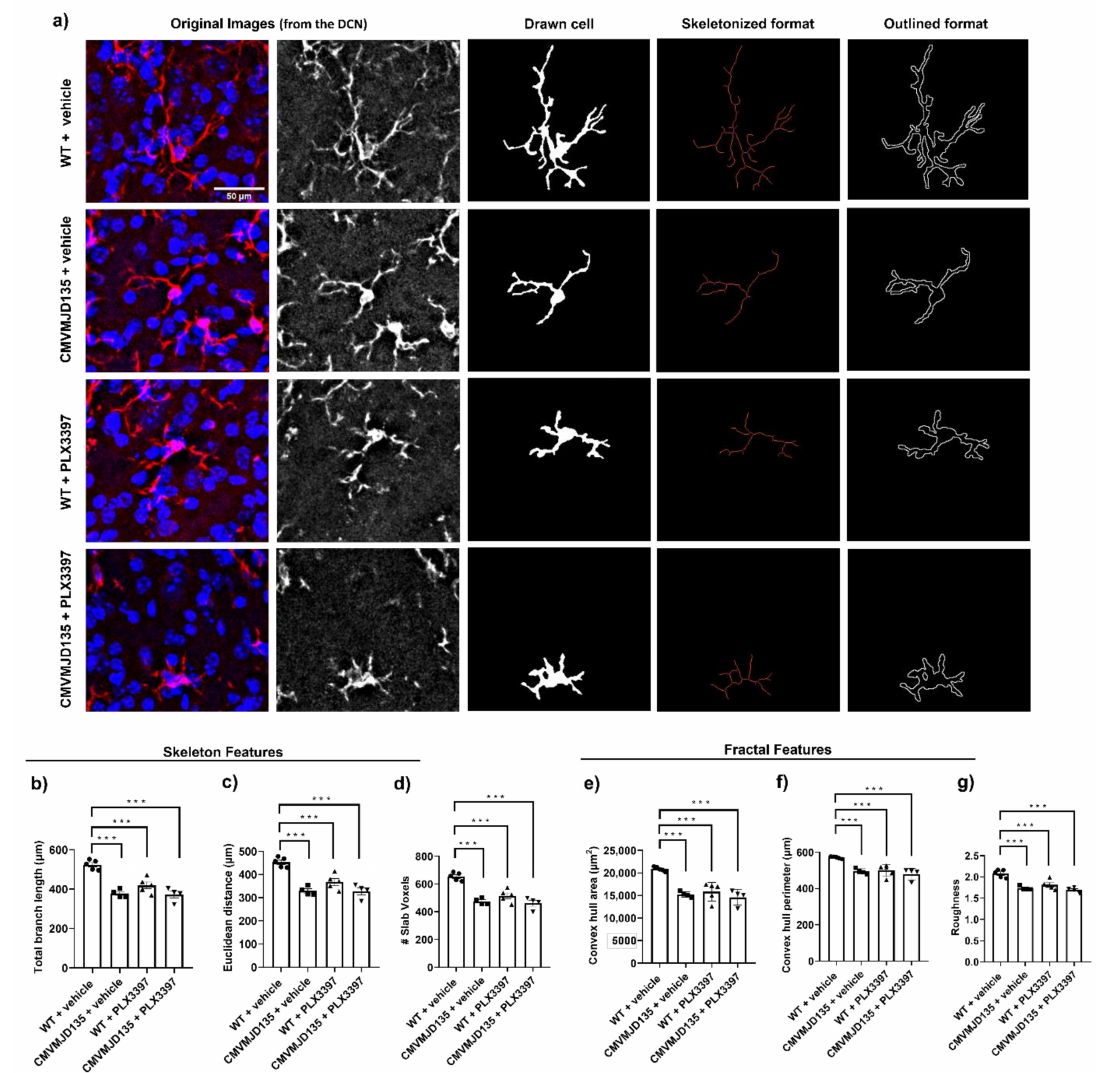
Figure 2. Treatment with PLX3397 did not induce morphological changes in the microglia in the DCN of CMVMJD135 mice at 21 weeks of age. ( a ) Representation of the process to prepare the images for skeleton and fractal analysis of microglia morphology. Quantification of the morphometric parameters associated to microglia ramification: ( b ) total branch length; ( c ) Euclidean distance; and ( d ) # slab voxels. Associated with cell size: ( e ) convex hull area; and ( f ) convex hull perimeter. Associated with cell surface: ( g ) roughness. Data of all these parameters were obtained from: 387 microglial cells from WT + vehicle mice ( n = 5); 256 microglial cells from CMVMJD135 + vehicle mice ( n = 4); 475 microglial cells from WT + PLX3397 mice ( n = 5); and 263 microglial cells from CMVMJD135 + PLX3397 mice ( n = 4). The symbols • , (cid:4) , (cid:78) , and (cid:72) stand for the WT + vehicle, CMVMJD135 + vehicle, WT + PLX3397, and CMVMJD135 + PLX3397 groups, respectively. Data are presented as mean + SEM (one-way ANOVA (post hoc Tukey’s test)). ***, represent p < 0.001. Scale bar 50 µ